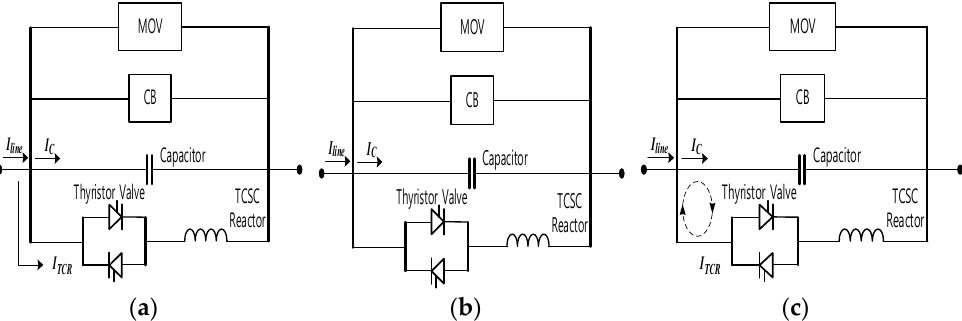
Figure 4. TCSC control mode. ( a ) Bypassed-thyristor mode. ( b ) Blocked-thyristor mode. ( c ) Capacitor vernier mode.